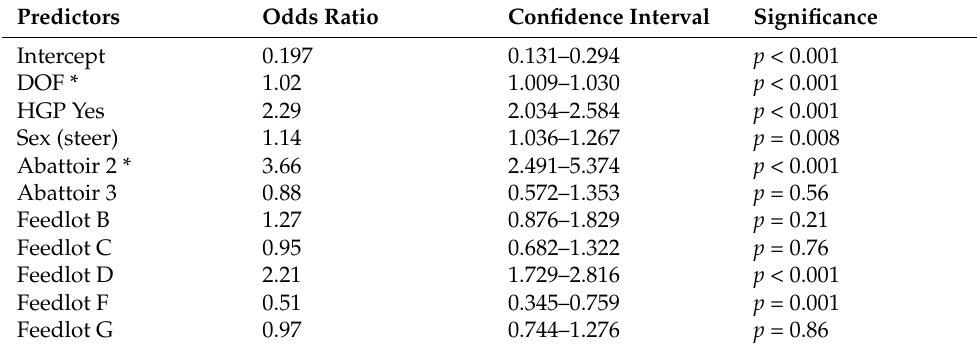
Table 4. Odds ratios of pH non-compliance for predictors including significant